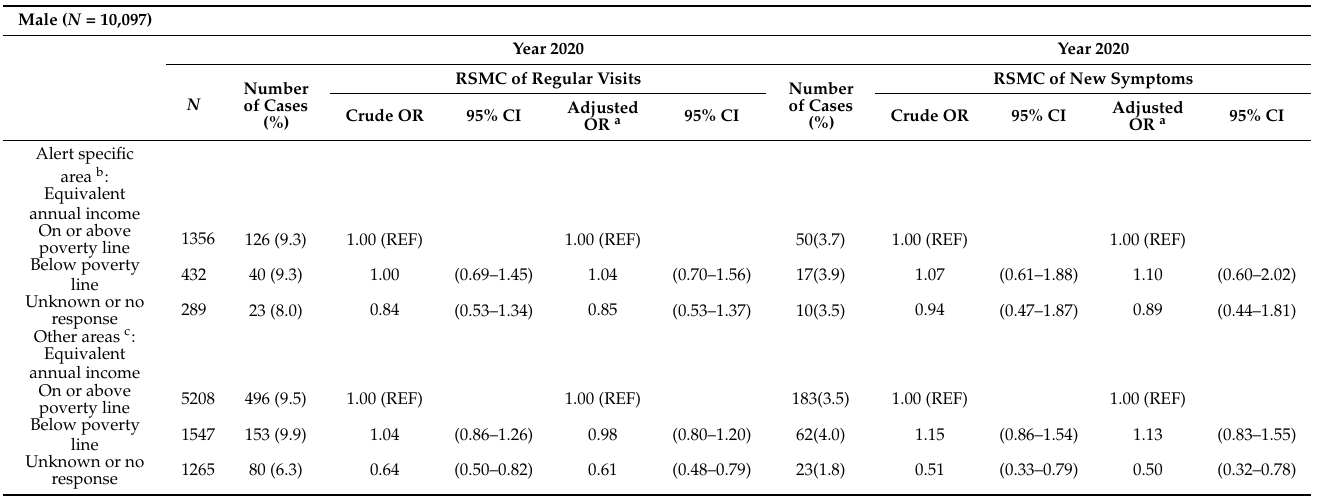
Table A4. Odds ratios (ORs) of household income for refraining from seeking medical care (RSMC) of regular visits and symptoms in 2020 according to alert specific